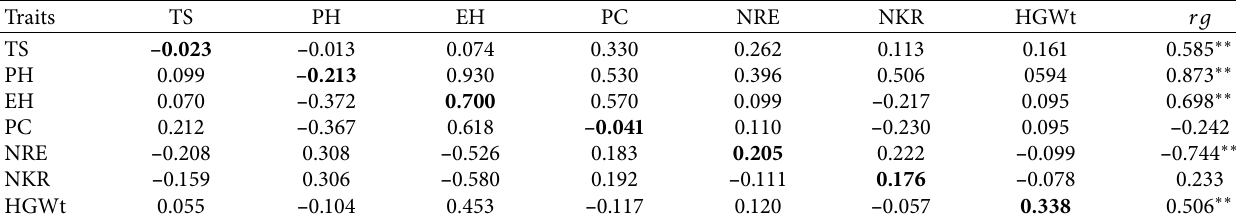
Table 4: Direct (boldface) and indirect effects of different traits on grain yield.